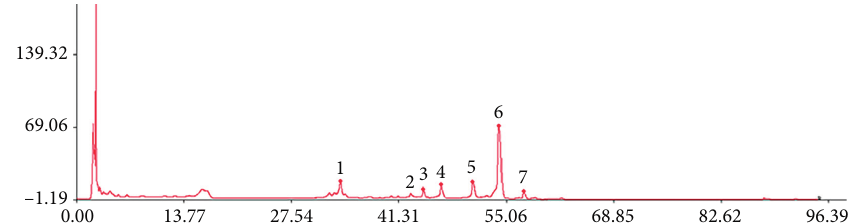
Figure 3: HPLC fingerprint of total saponins of Glycyrrhiza uralensis Fisch. from 21 producing areas.